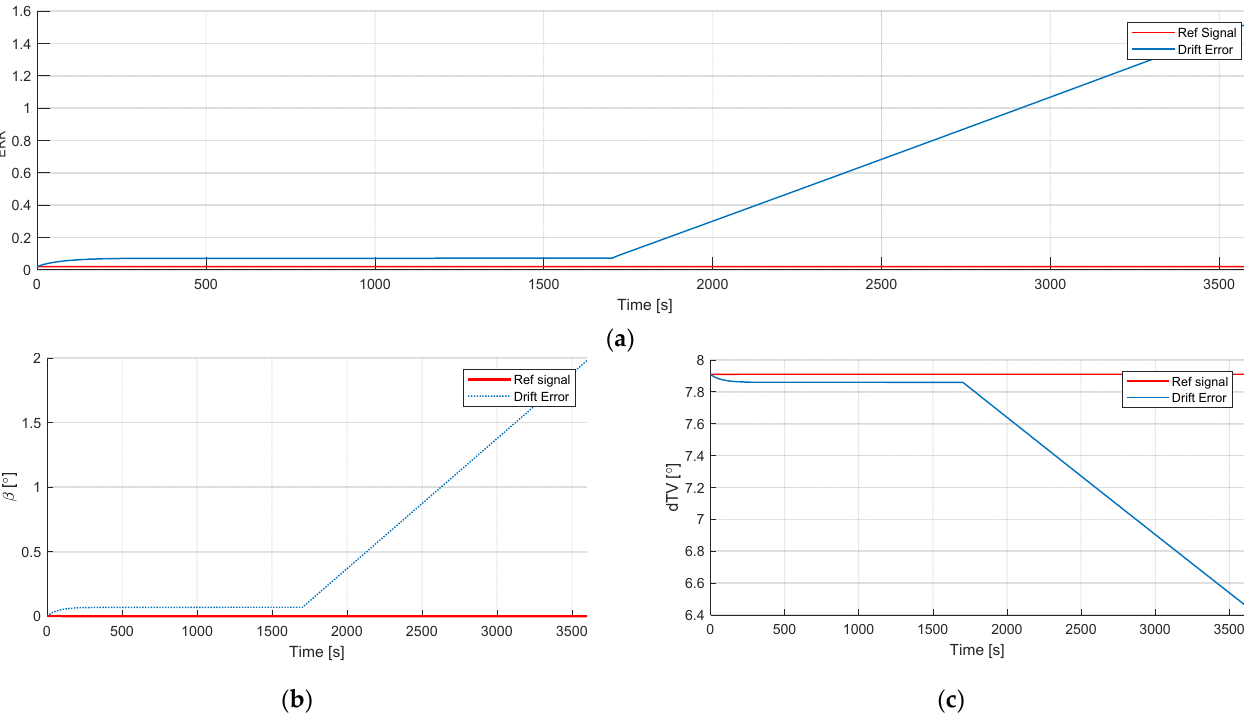
Figure 12. Influence of drift of TSoS on a stable flight: ( a ) Comparison of heading error; ( b ) Comparison of angle of sideslip; ( c ) Comparison of rudder trimmer deflection.